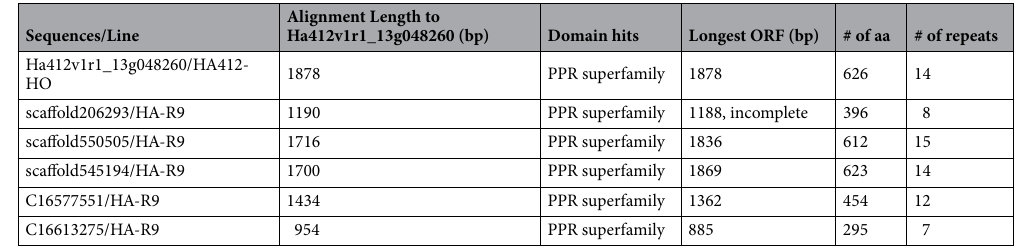
Table 5. Prediction of the candidate gene for Rf5.